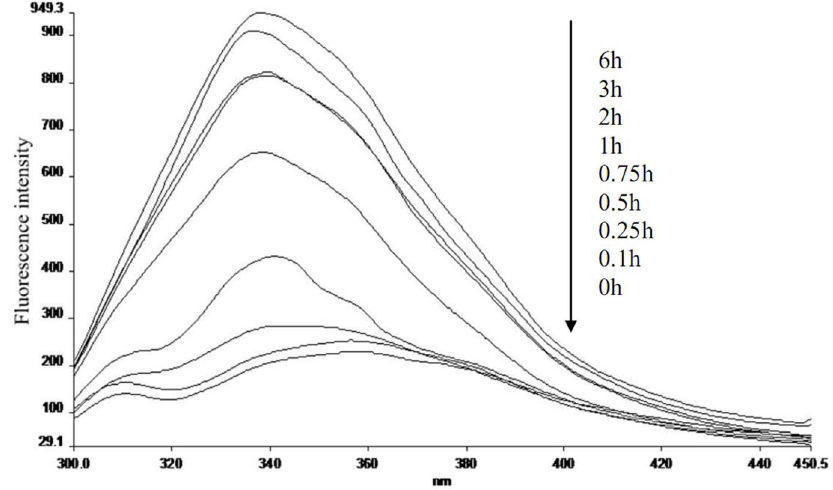
Figure 1. Intrinsic fluorescence spectra of aggregates according to incubation time. doi:10.1371/journal.pone.0109439.g001 PLOS ONE |